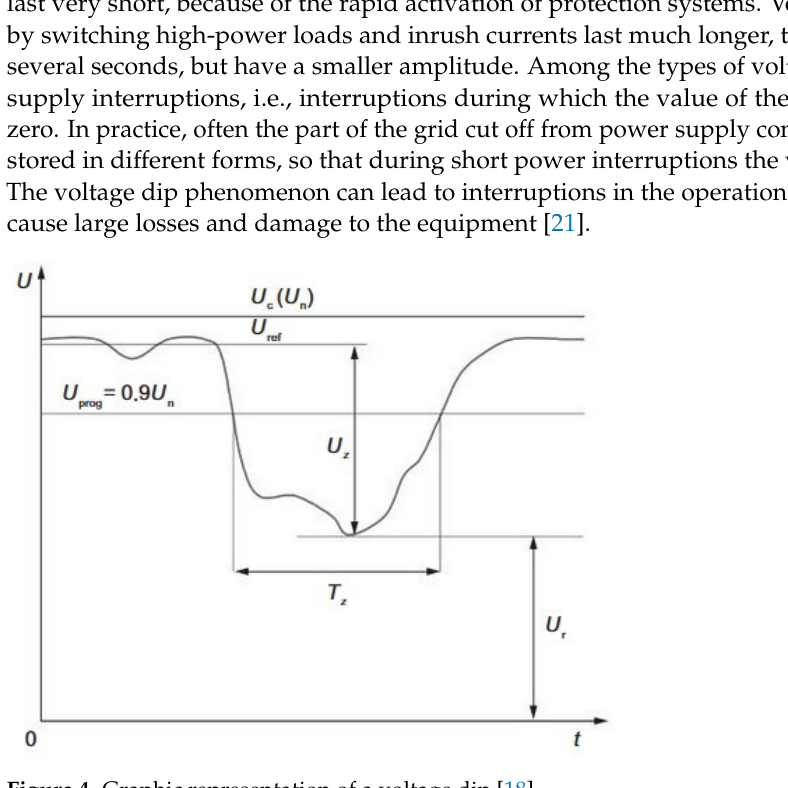
Figure 4. Graphic representation of a voltage dip [18].